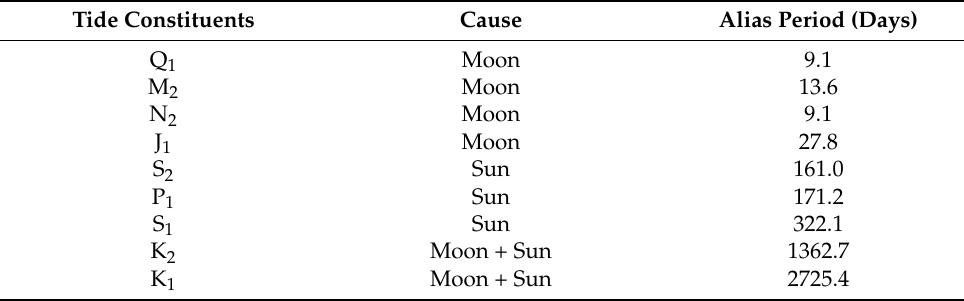
Table 1. Tide constituents and their alias period in